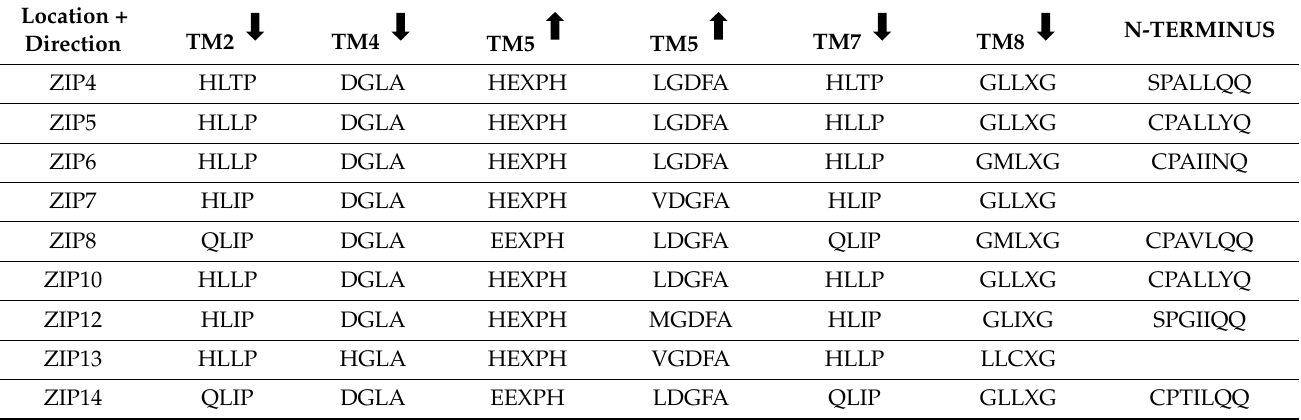
Table 2. Conserved TM motifs in the LIV-1 family of zinc transporters. The table below shows the conserved motifs in TM domains of the nine human members of the LIV-1 family of zinc transporters as well as the N-terminal CPALLY motif. The arrows indicate the direction of the motif within the TM domain showing consistency in each protein, the down arrow represents the positioning from the outside towards the cytoplasm, whereas the up arrow represents the reverse direction.